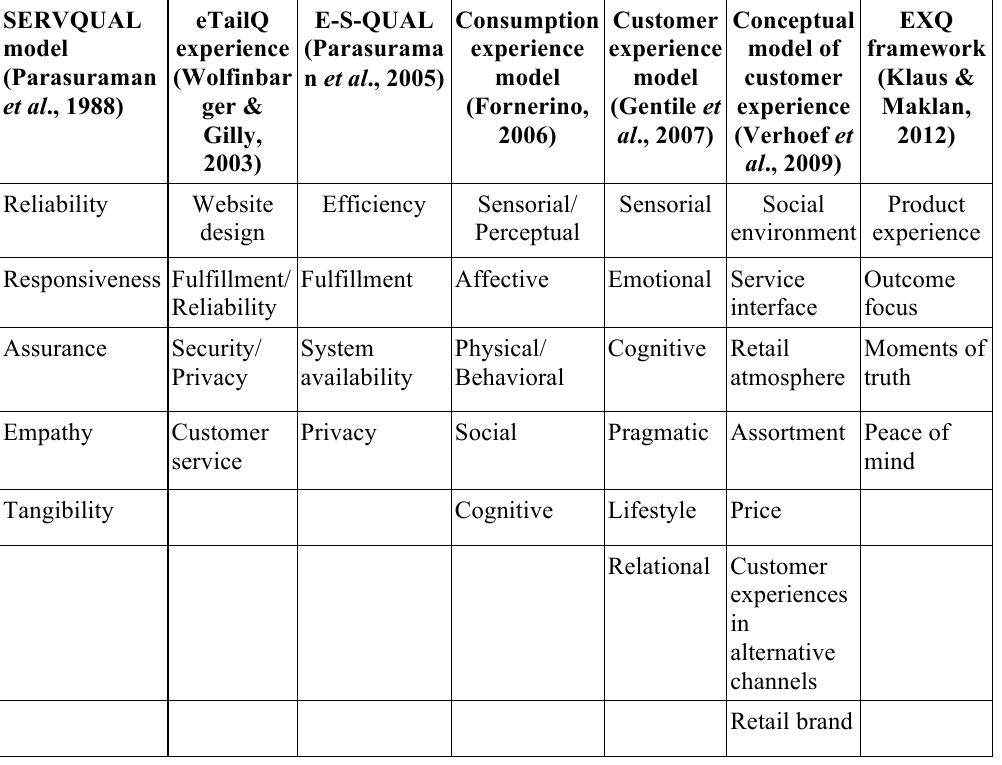
Table 1. Overview of the dimensions of customer experience